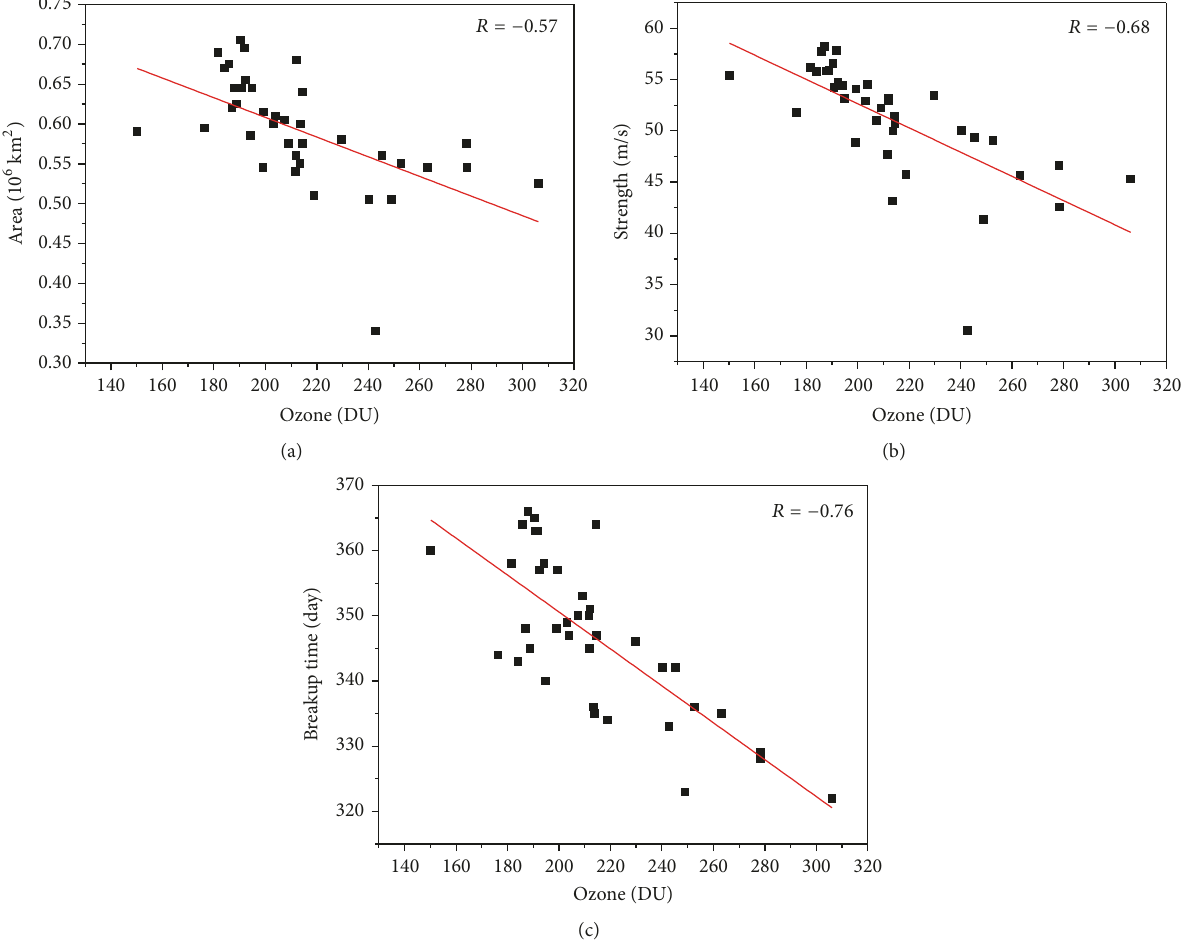
Figure 6: Scatterplots of (a) polar vortex area, (b) polar vortex strength, and (c) polar vortex breakup time versus total column ozone within the polar vortex for 38-year (1979–2016) record. The linear correlation coefficients are given in the top right of each